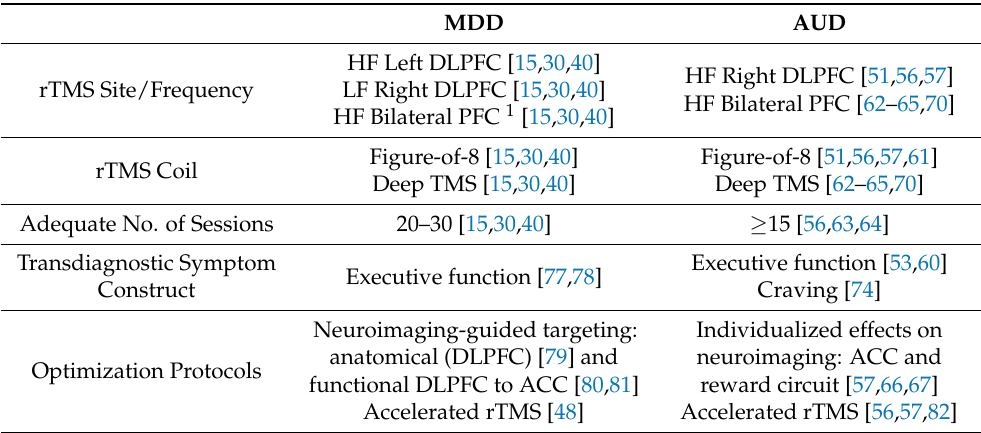
Table 2. Selected literature of converging directions for repetitive transcranial magnetic stimulation (rTMS) in major depressive disorder (MDD) and alcohol use disorder (AUD). MDD AUD HF Left DLPFC [15,30,40] rTMS Site/Frequency LF Right DLPFC